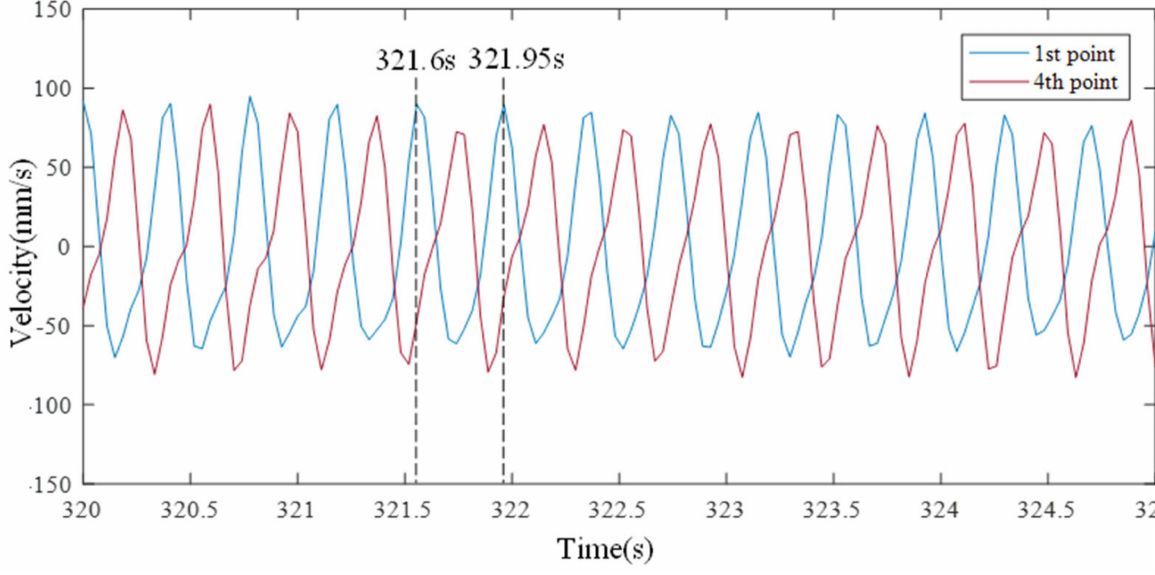
Figure 17. Time histories at the third natural frequency.